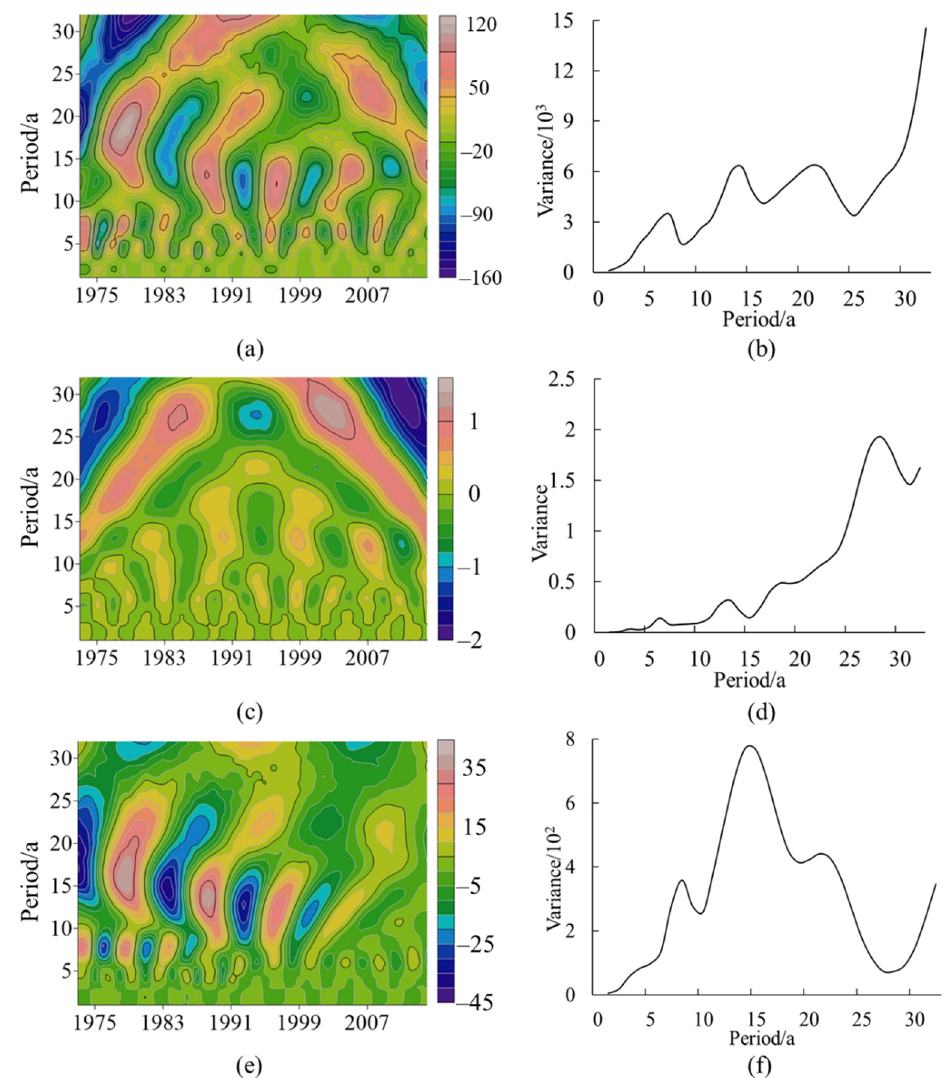
Figure 5. The real part distribution and variance of Morlet wavelet for precipitation ( a , b ), temperature ( c , d ), and runoff ( e , f ) series.